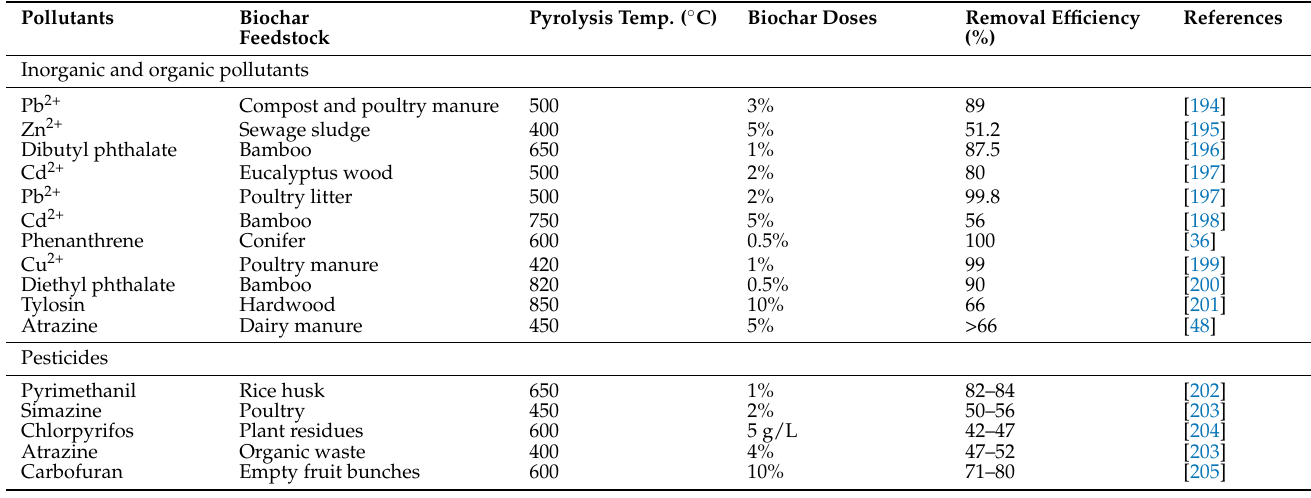
Table 4. Potential of biochar produced from various feedstocks for the removal of organic and inorganic pollutants from